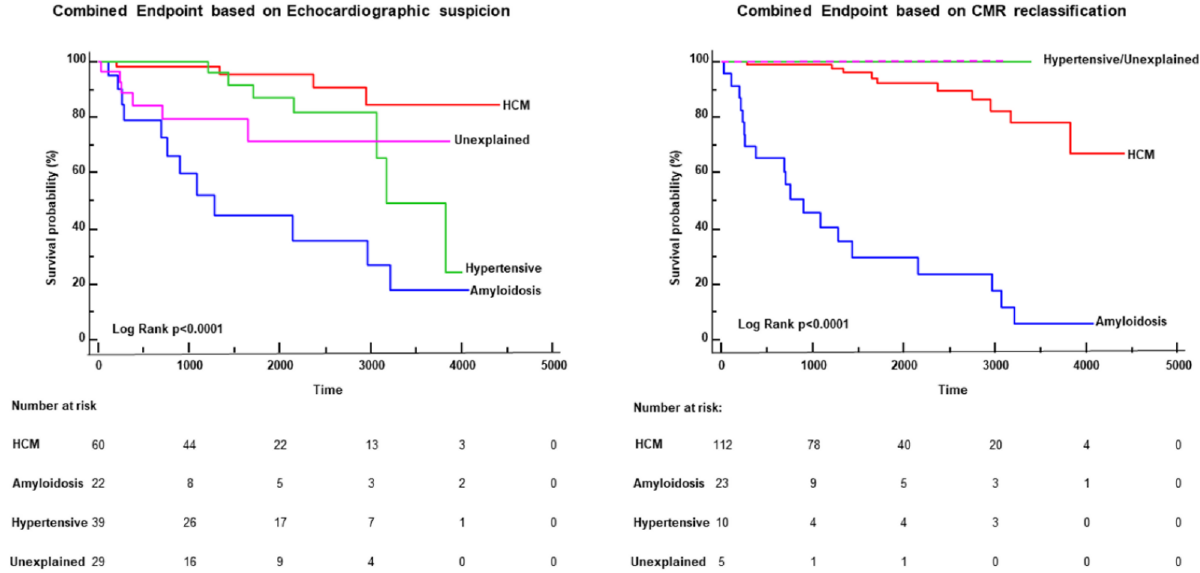
Figure 4. Kaplan–Meier curves: The graphs represent the survival-free events curve of the patients with the 4 major diagnoses in this population: hypertrophic cardiomyopathy (HCM), cardiac amy- loidosis, hypertensive left ventricular hypertrophy (LVH) and undetermined LVH. The left graph shows the curves based on the initial echocardiographic suspicion, and the right graph was the result of the reclassification made by cardiac magnetic resonance (CMR). As is evident, the reclassification allowed a prognostic change in survival curves: no events occurred in patients with hypertensive LVH and those with undetermined LVH based on CMR